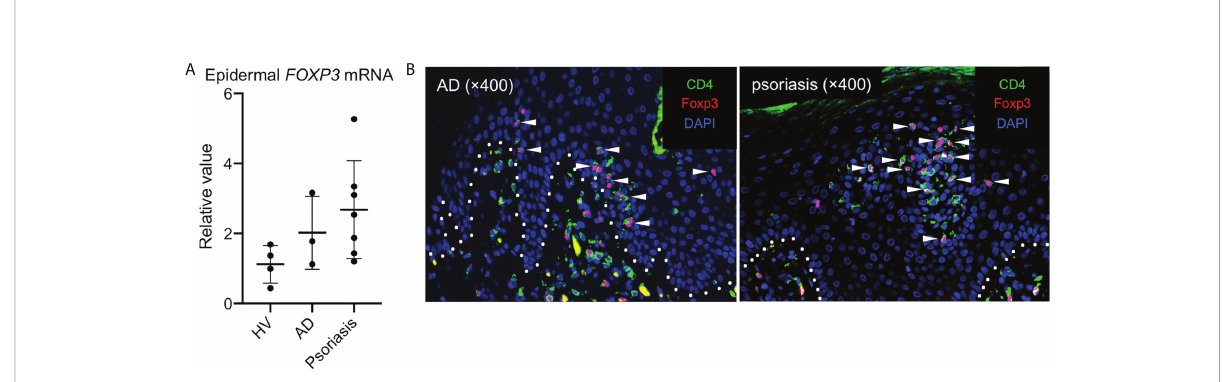
FIGURE 4 Tregs in the epidermis of in fl ammatory skin conditions. (A) A summary of FOXP3 mRNA expression in the epidermis of indicated samples (HV: healthy volunteers and AD: atopic dermatitis). (B) Representative CD4 and Foxp3 staining in the skin of patients with AD ( left ) and with psoriasis ( right ). All the experiments were conducted using at least three different samples. Arrowheads in (B) indicate costained cells in the epidermis.